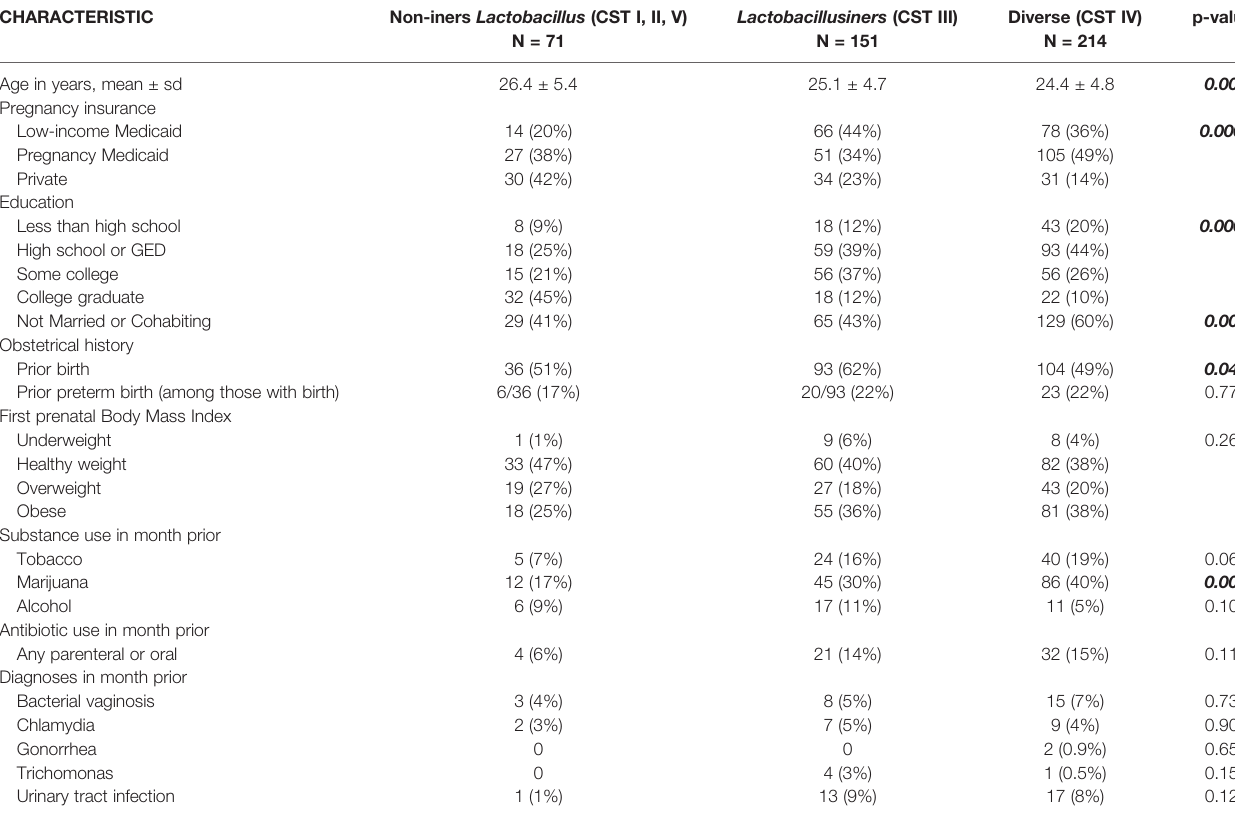
TABLE 3 | Sociodemographic and Clinical Characteristics of Women According to CST Category.